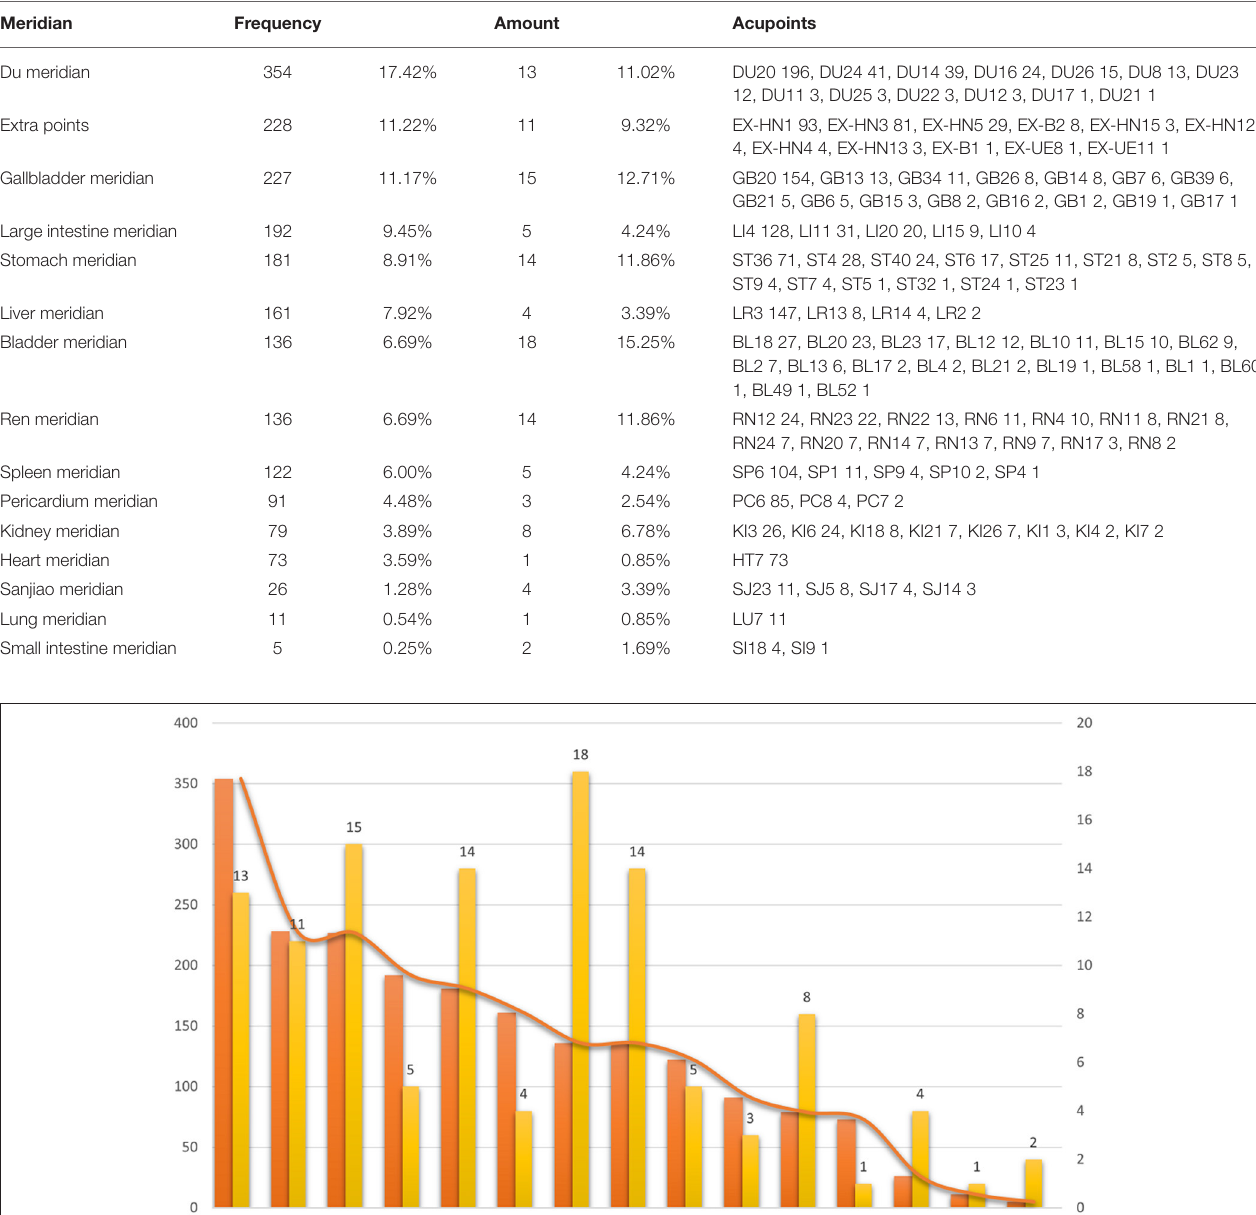
TABLE 2 | Frequency of meridian application for TD treatment.